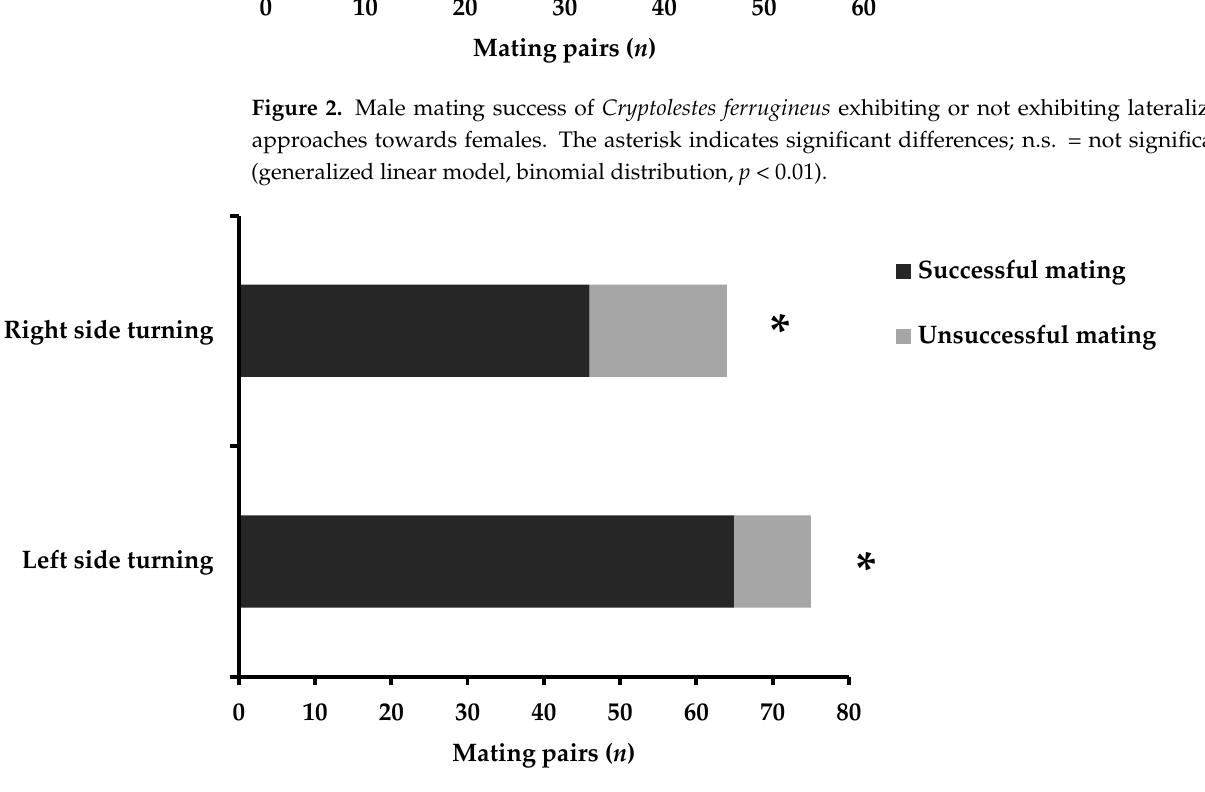
Figure 3. Male mating success of Cryptolestes ferrugineus performing lateralized turning before genital contact with female. The asterisk indicates significant differences; (generalized linear model, binomial distribution, p < 0.01).